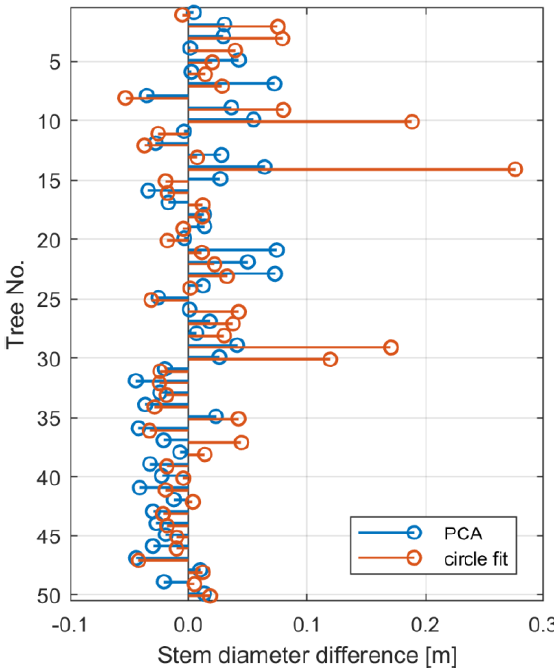
Figure 6. Comparison of stem diameters from field measurements with diameters detected for the leafless period using the two